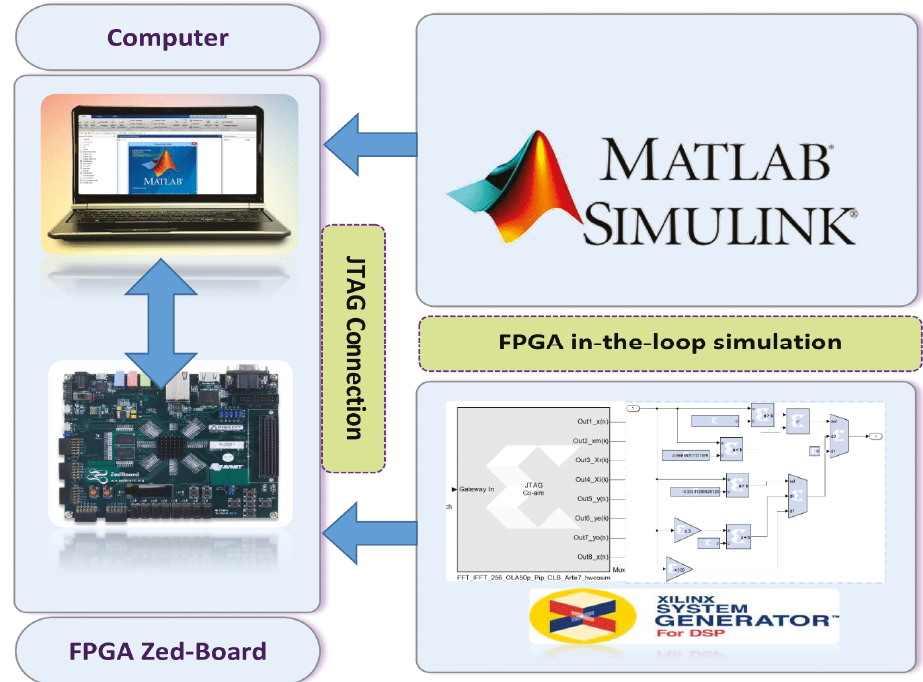
Figure 35. Hardware Figure (cid:561) 35. (cid:561) Hardware (cid:561) co-simulation. (cid:561)